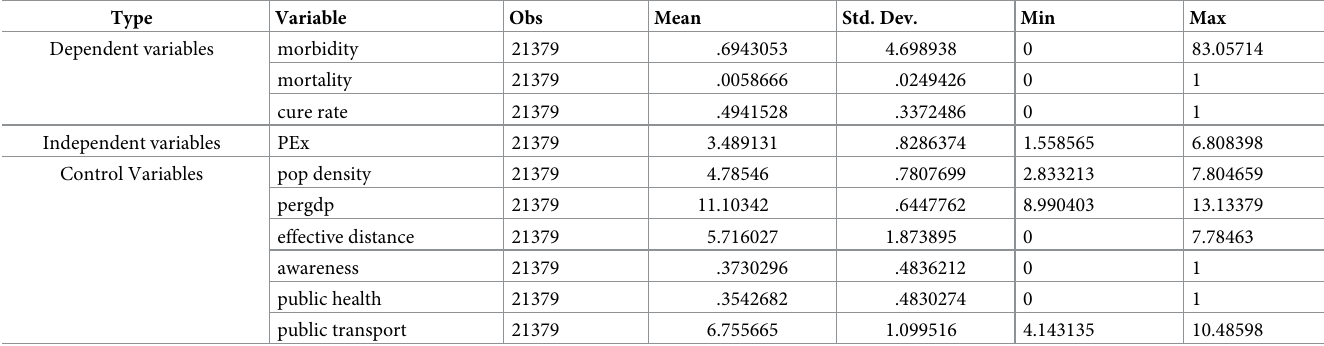
Table 1. Statistical description.